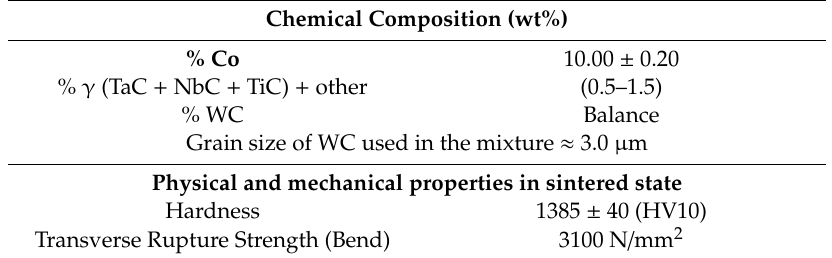
Table 3. Chemical composition, physical and mechanical properties of the PH7930 substrate.